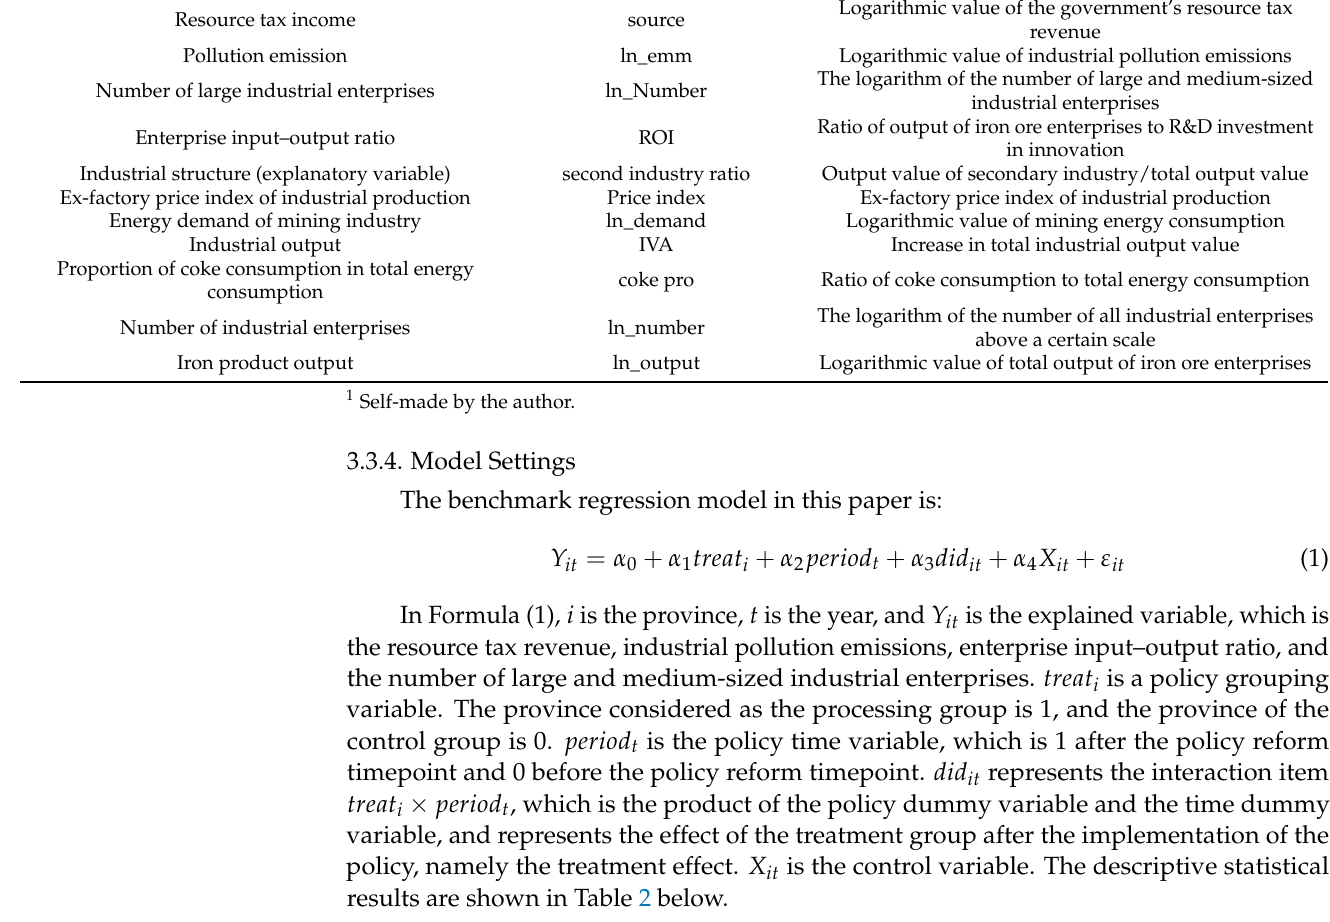
Table 2. Data descriptive statistical results 1